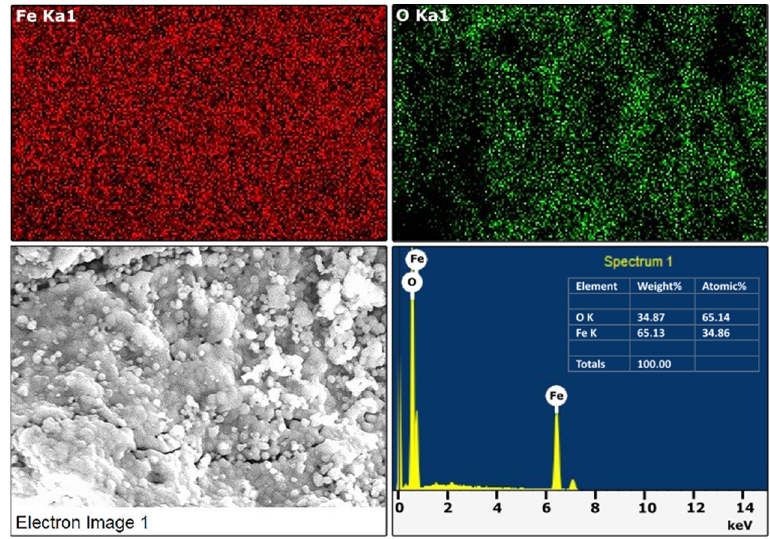
Figure 3. Elemental color mapping of α‐ Fe 2 O 3 and EDS spectra.